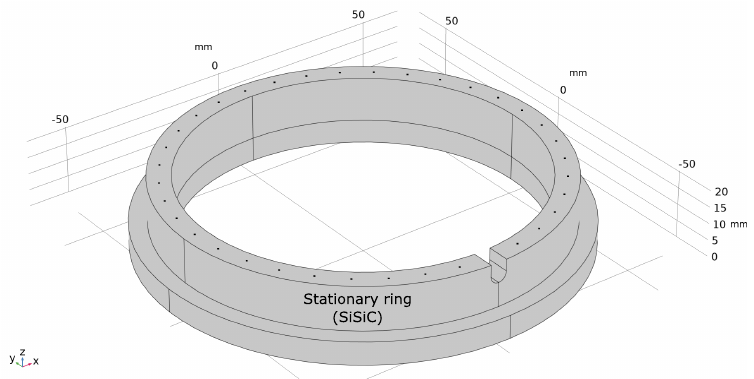
Figure 4. Model of the stationary ring for evaluating the eigenfrequencies and the corresponding mode shape.